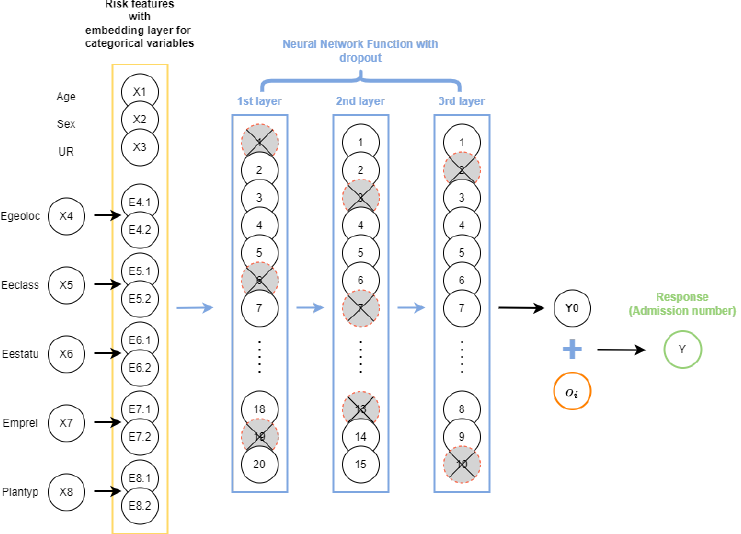
Figure 10. An illustration of dropout process for a sample NN model with three hidden layers and 20,15,10 neurons in each layer. The gray crossed-out circles in each layer represent the neurons that were randomly dropped with probability p